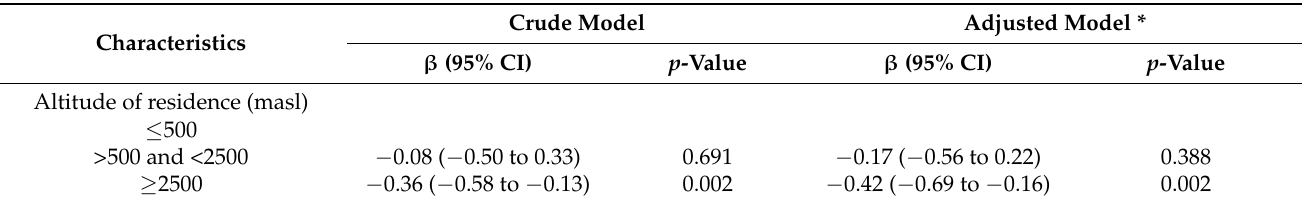
Table 3. Association between altitude and the Framingham risk